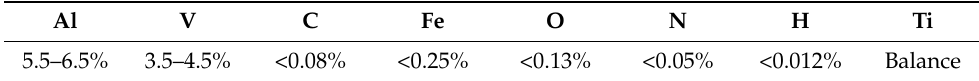
Table 1. Chemical composition of Ti6Al4V used for fabrication of